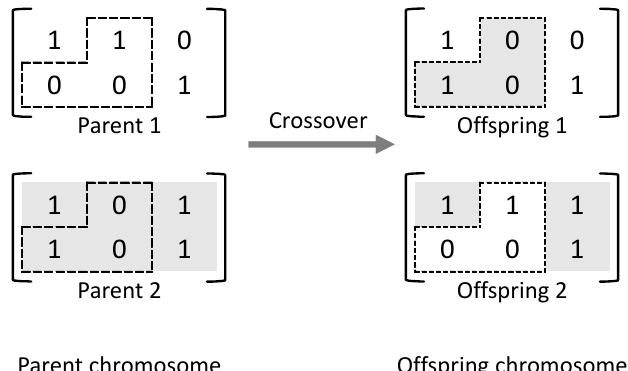
Figure 2. Example of